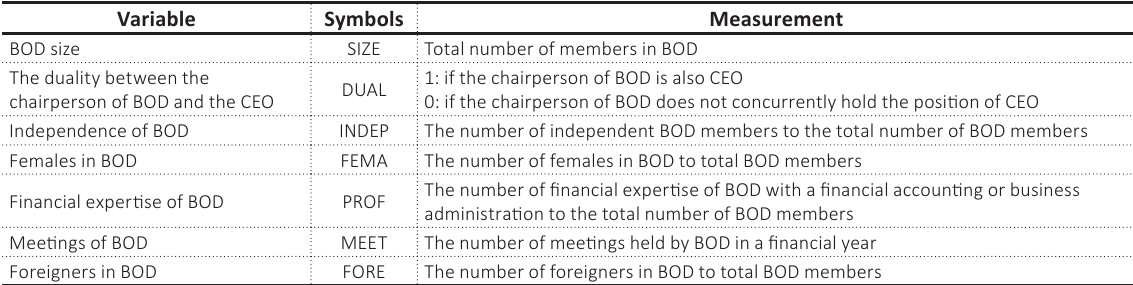
Table 1. Description of the independent variables